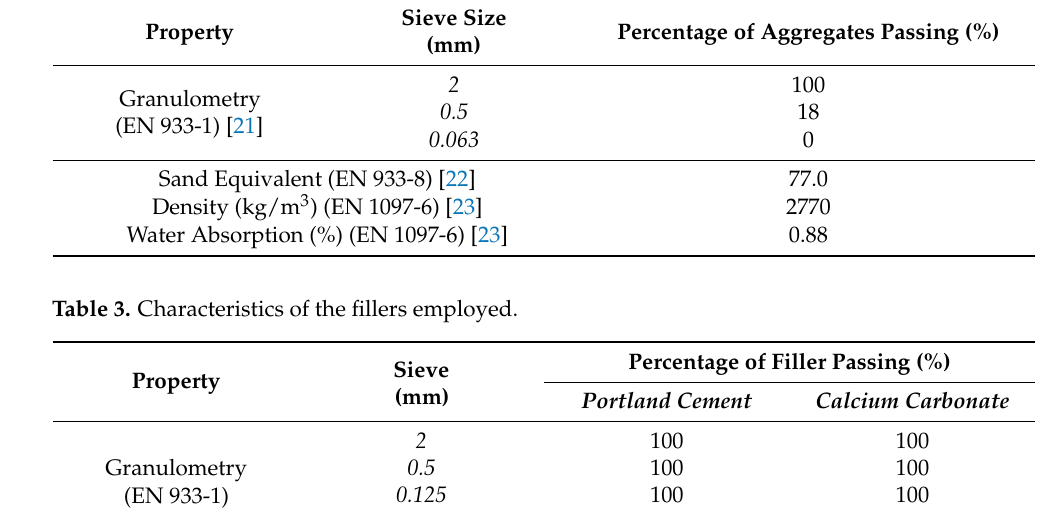
Table 2. Characteristics of the sand employed.